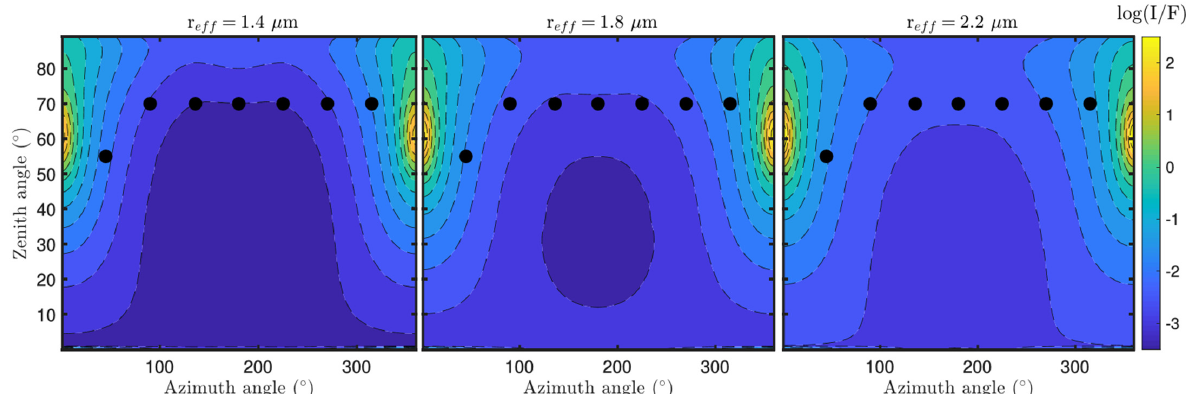
Figure 22. Same as Figure 21 but for different values of the effective radius r eff .